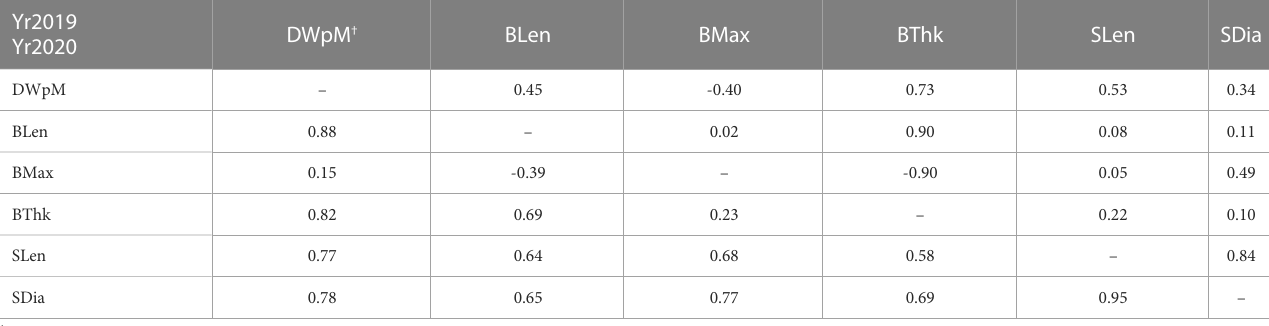
† For trait abbreviations refer to Table 1. Analysis was done within years. The genetic correlation values for Yr2019 are in the upper diagonal and for Yr2020 are in the lower